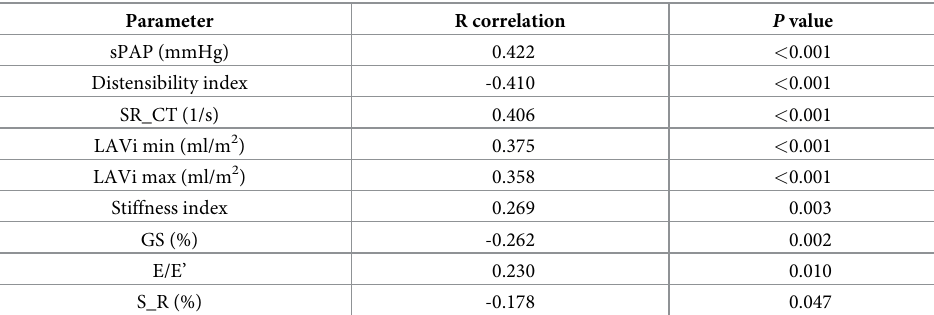
Table 4. Correlations between NT-proBNP and echo